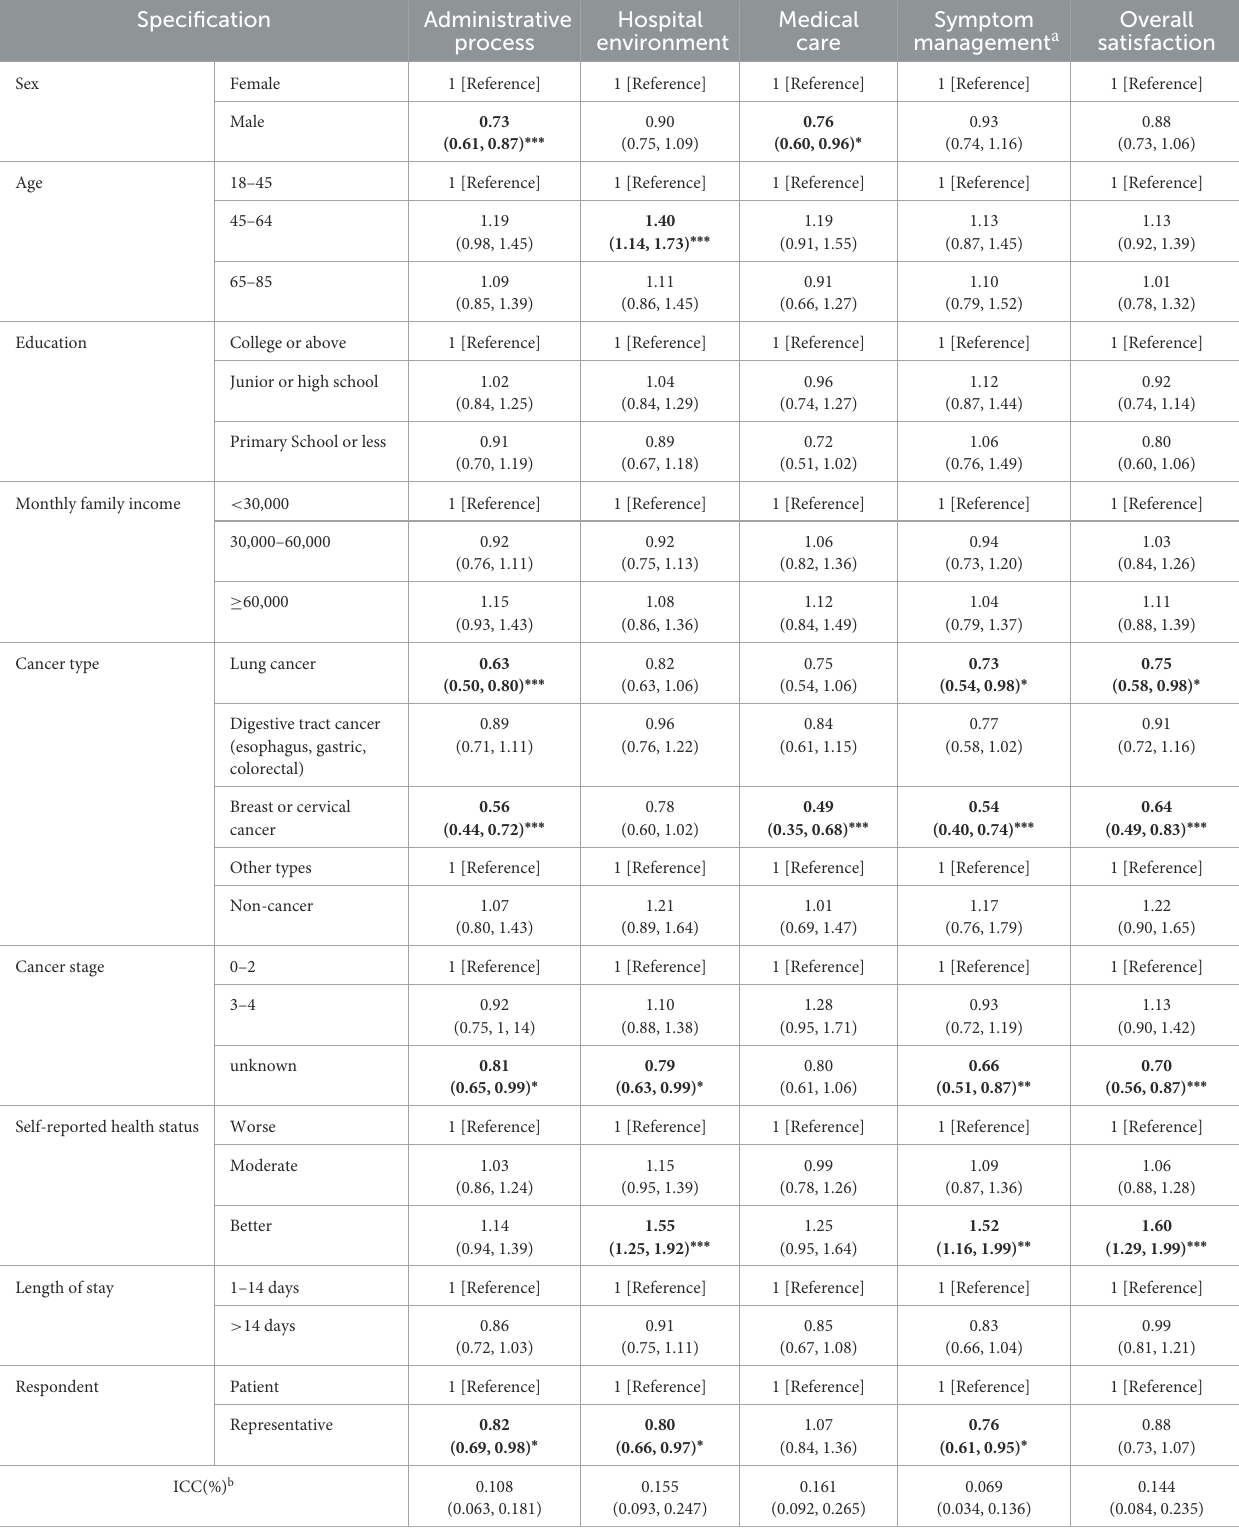
a Samplesizeofsymptommanagementwas2,276becausenotallpatientshadundergoneclinicalsymptomssurveyed. ∗ P < 0.05, ∗∗ P < 0.01, ∗∗∗ P < 0.001. b RepresentICCandits95%confidenceintervalaftercase-mixadjustment.BoldORwith95%confidenceintervalisbeyondorbelow1.